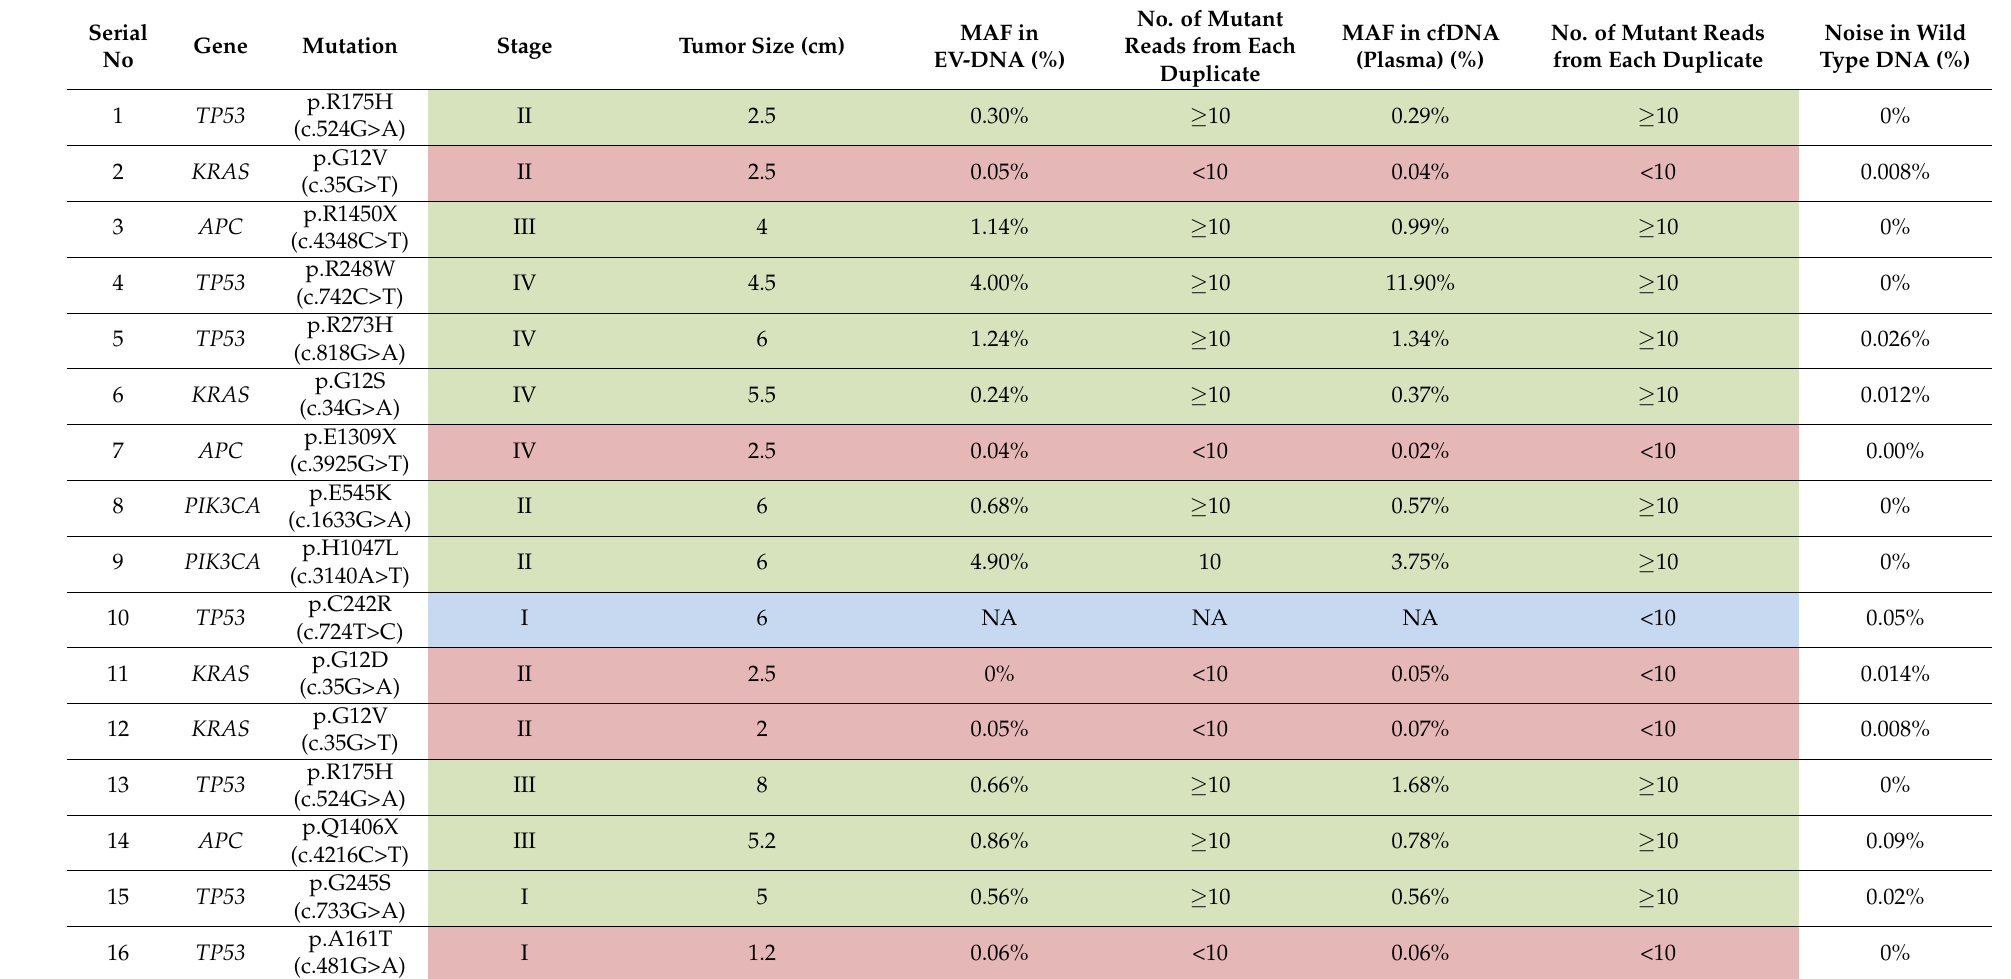
Table 2. Mutation analysis from EV-DNA and